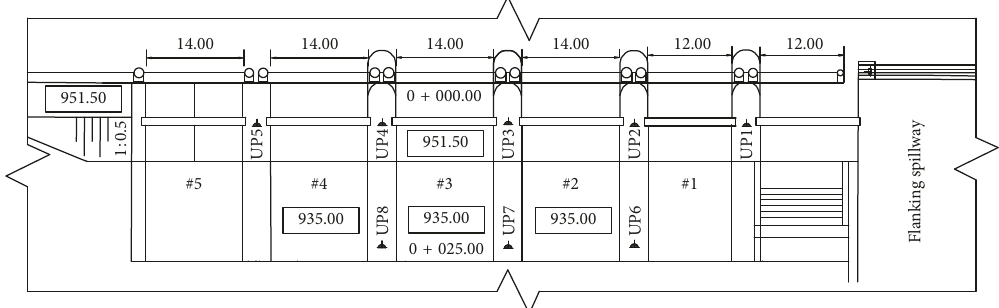
Figure 4: Seepage monitoring layout for sluice foundation.